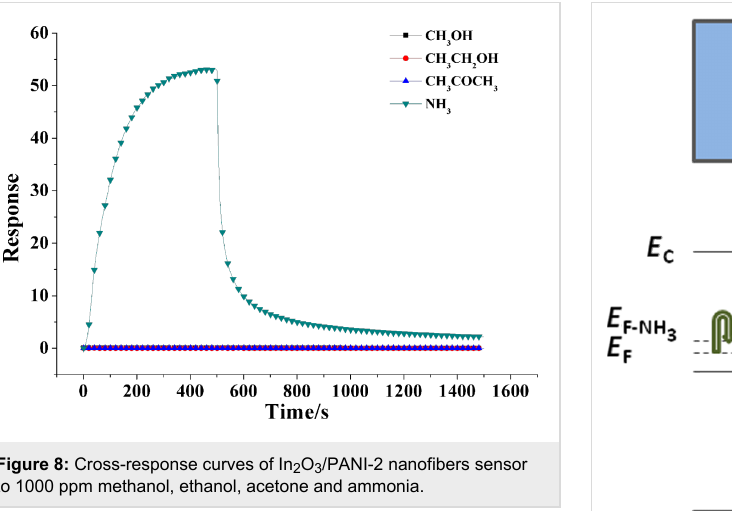
Figure 8: Cross-response curves of In 2 O 3 /PANI-2 nanofibers sensor to 1000 ppm methanol, ethanol, acetone and ammonia.